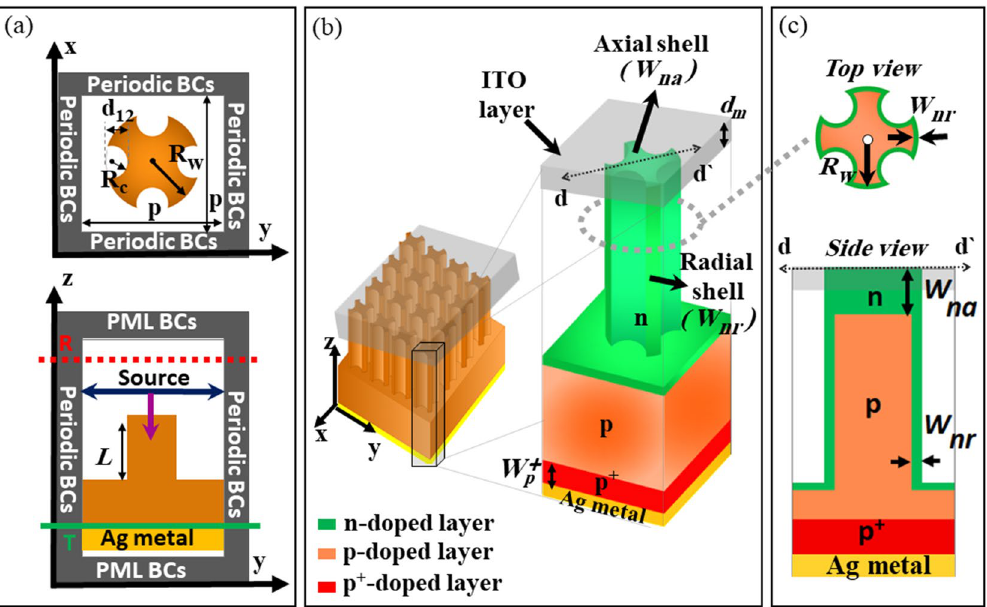
Figure 1. ( a ) Computational domain of the single unit cell in 2D plane. ( b ) 3D schematic diagram. ( c ) 2D top + and side view of the proposed design in core–shell n / p / p junction. The green region is n-doped, the orange region is p-doped, and the red region is the highly p-doped. This image is created by Lumerical 2020a, FDTD Solver Version 8.23.2305, https:// www. lumer ical. com (license number-12802) released to Zewail City of Science and Technology, Giza, Egypt.